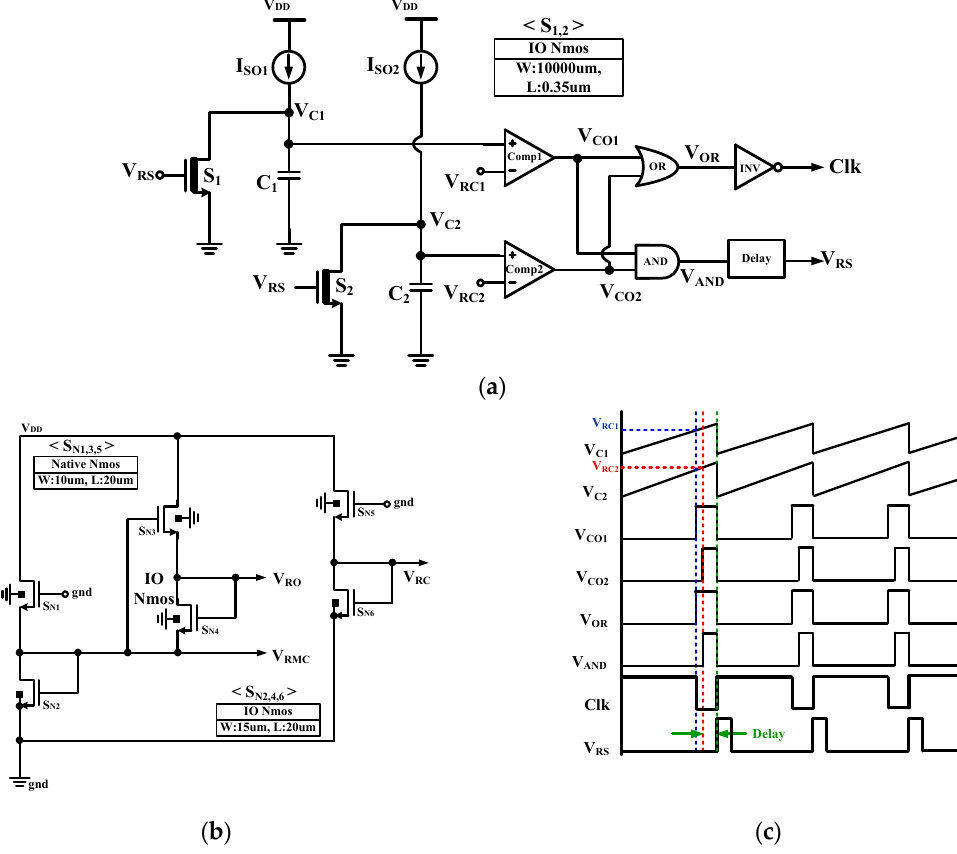
Figure 10. The proposed ( a ) on-chip MPPT period controller, ( b ) on-chip reference generator, and ( c ) the detailed operation waveforms of on-chip MPPT period controller.